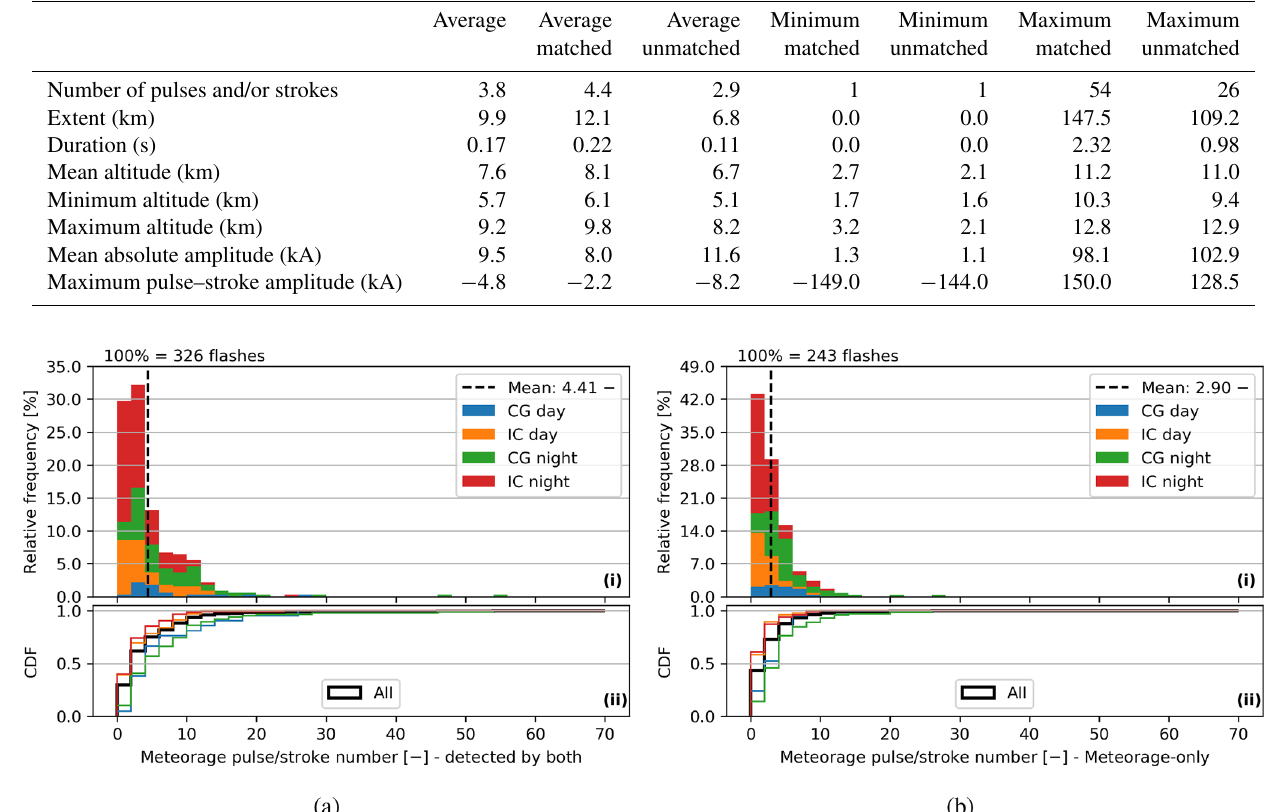
Figure 10. Pulse–stroke number of Meteorage flashes with a coincident ISS-LIS flash (a) and unmatched Meteorage flashes (b) . Daytime, nighttime and flash type, IC and CG, are indicated by the colors. The histogram (i) and corresponding CDF (ii) use the same colors. The CDF additionally shows a black curve for all data. The histogram bin width is constant at two pulses and/or strokes. The mean value is plotted as a dashed line. The total number of flashes is indicated above the